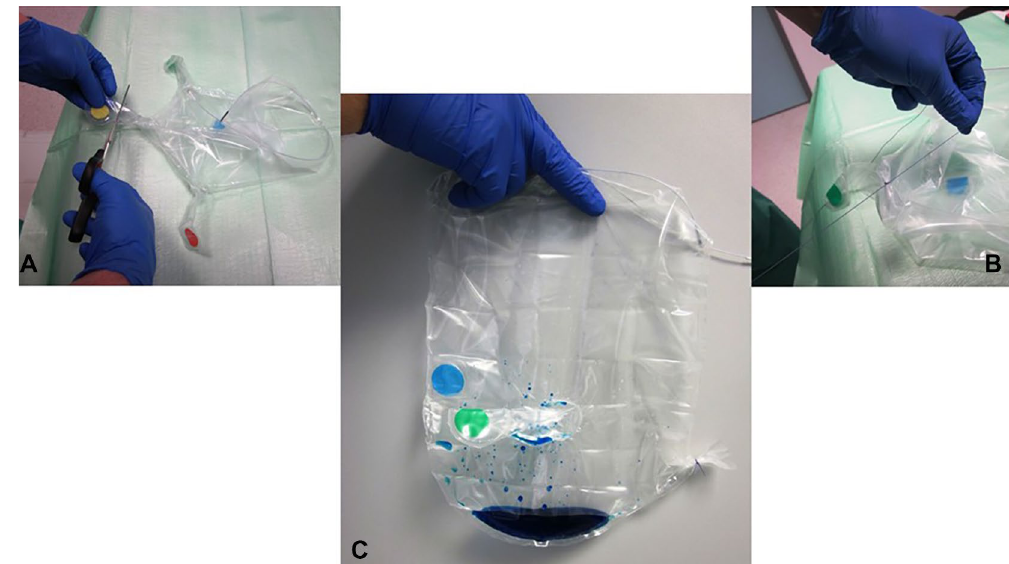
Figure 3. ( A ) Incision of the trocar sleeve; ( B ) Trocar sleeve is being re-sealed; ( C ) Blue dye inside the